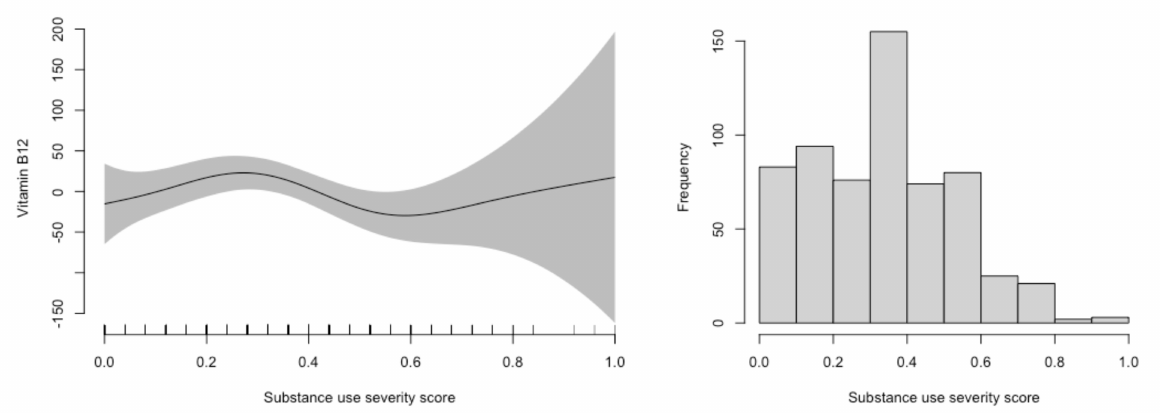
Figure 2. Association of substance use severity with serum vitamin B12 concentration. The figure to the left was constructed using generalized additive models in R and displays of the associations of vitamin B12 concentration in serum with the substance use severity index. The solid line depicts the association at various severity scores, whereas the shaded area represents the 95% confidence interval of this association. The figure to the right displays the distribution of substance use severity scores in the